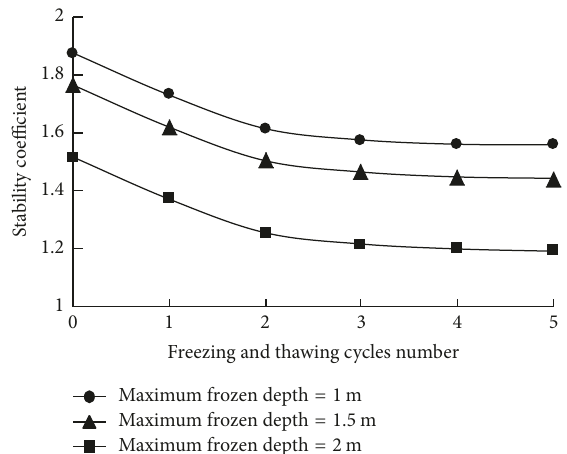
Figure 12: Variation of slope stability coefficient with number of the freezing and thawing